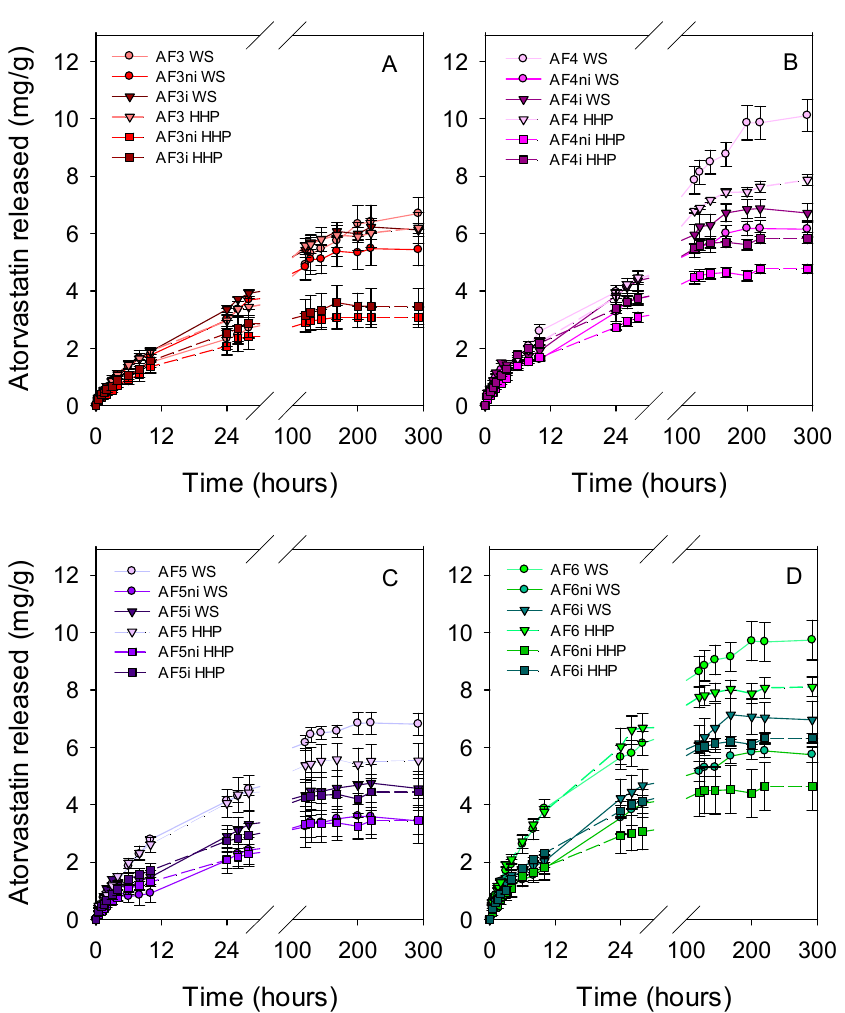
Figure 9. Comparison of atorvastatin release profiles from hydrogels that had not been sterilized (WS) and hydrogels that had been sterilized by high hydrostatic pressure (HHP) before loading. ( A ) F3 series, ( B ) F4 series, ( C ) F5 series, and ( D ) F6 series. Codes as in Table 1 ( n = 4; mean values and standard deviations).